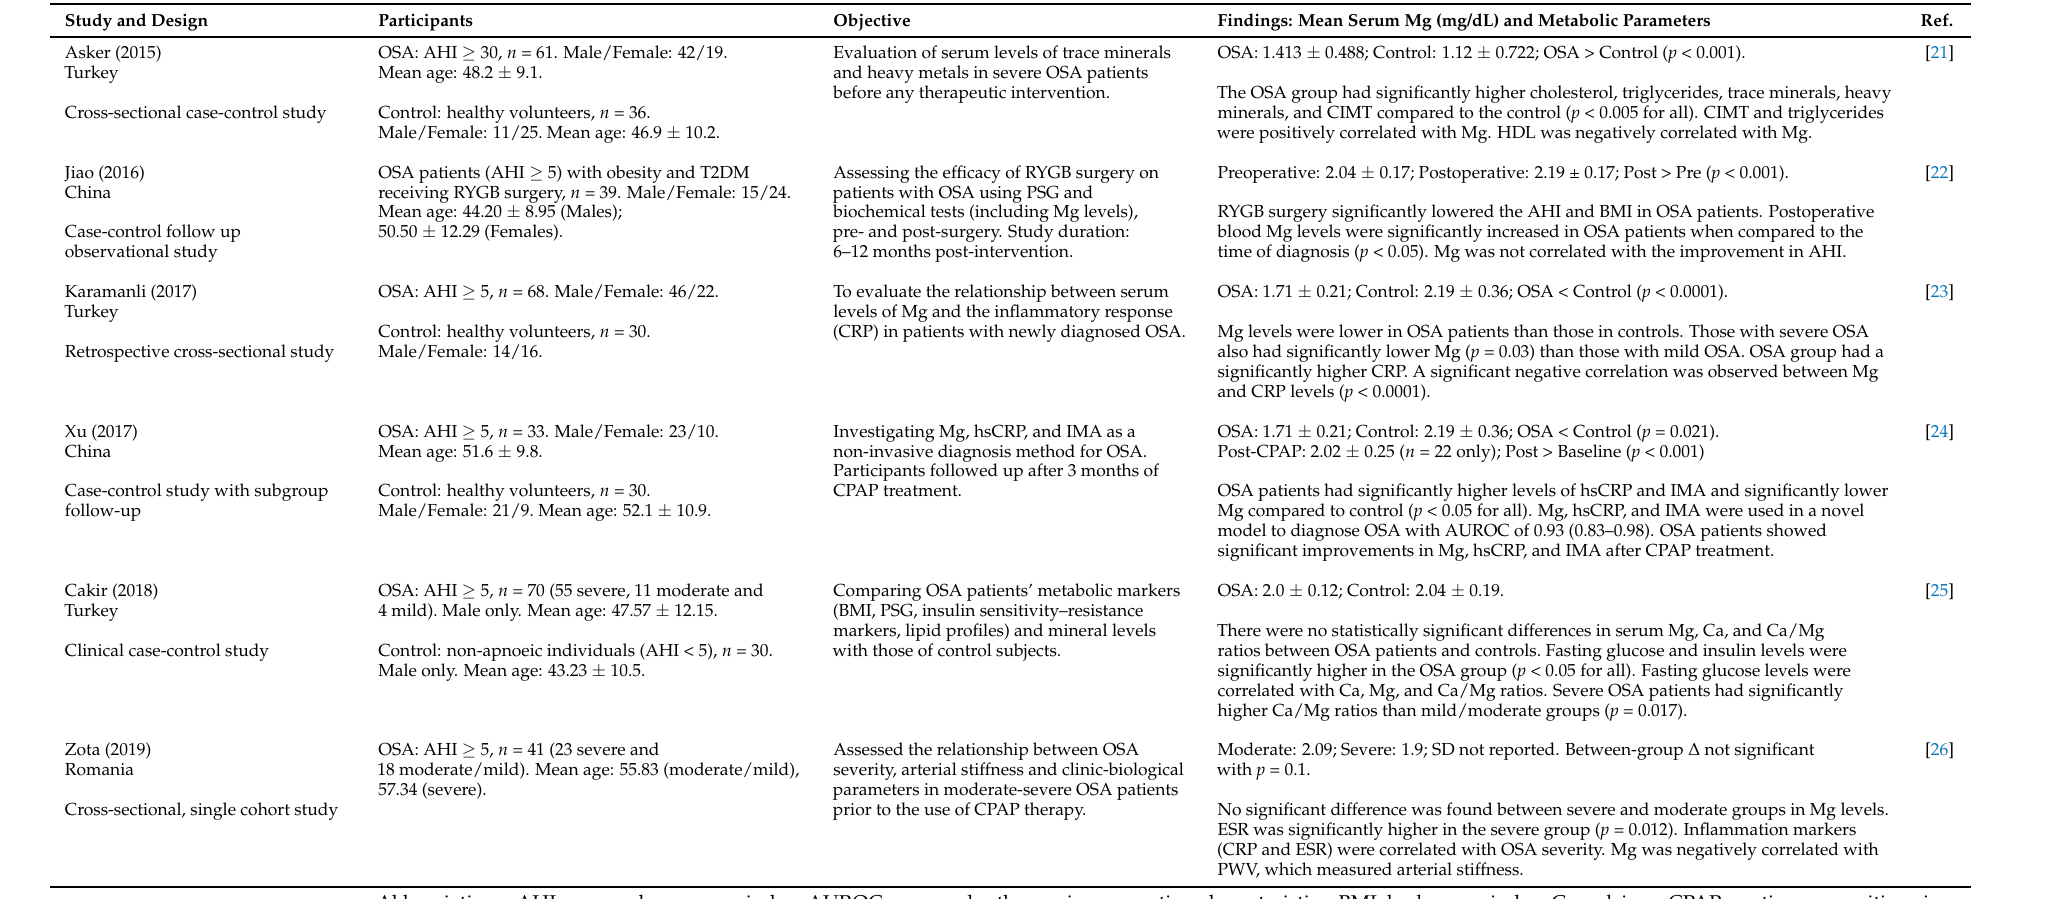
Table 1. Characteristics of the included